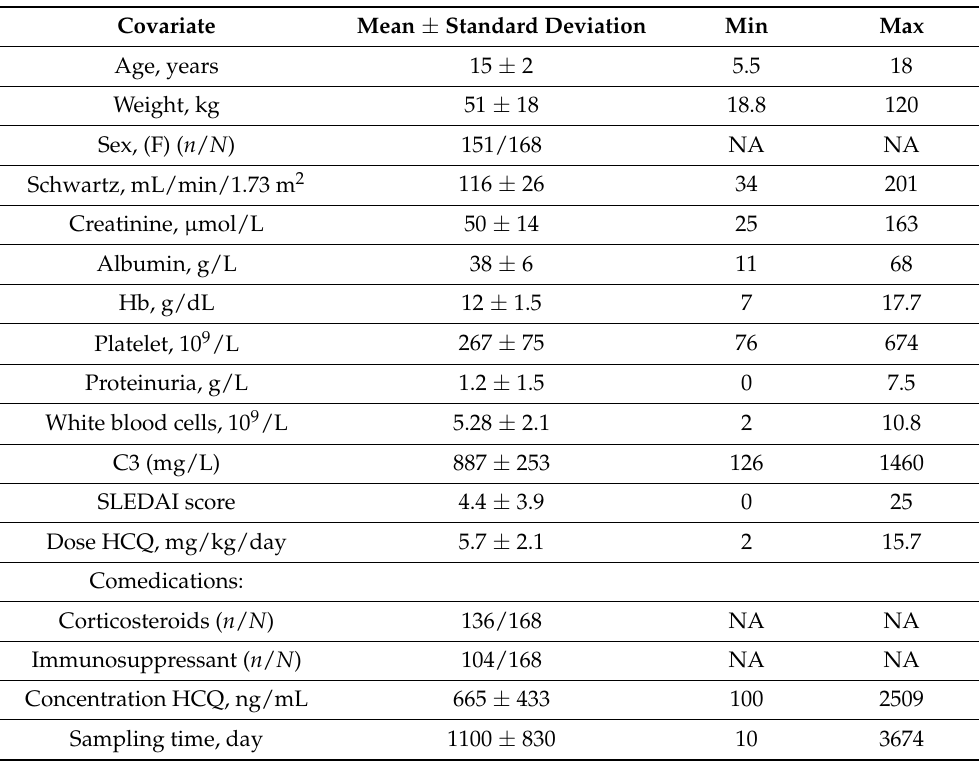
Table 1. Demographic, biological, and disease characteristics of the 55 patients.